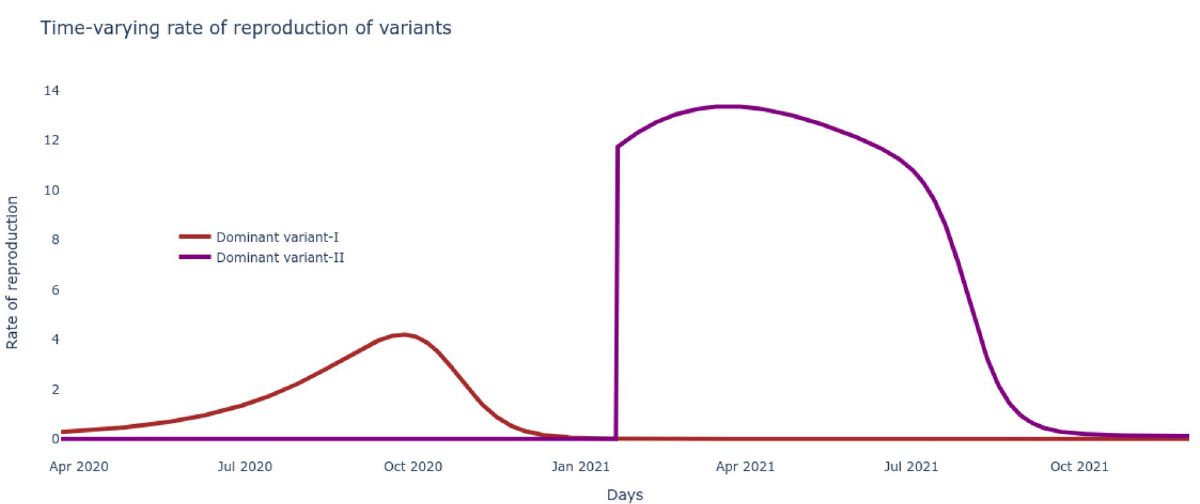
Figure 5. The time-varying rate of reproduction for the two dominant variants reveals a delta wave to be more